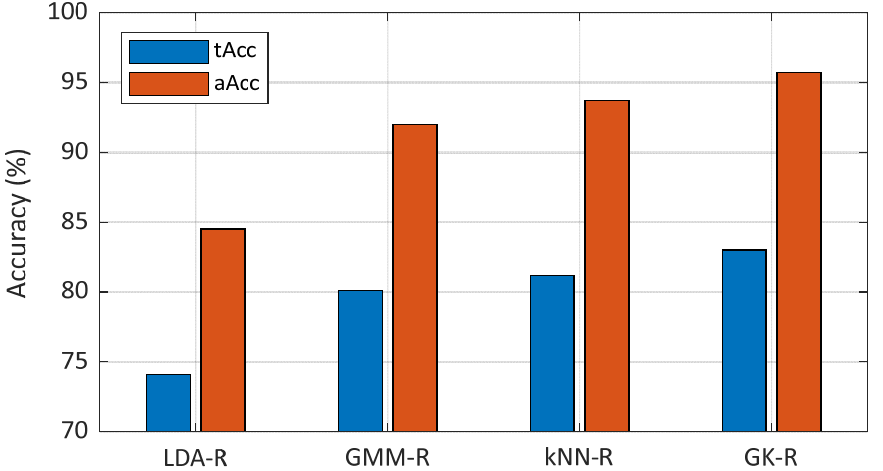
Figure 5. Comparison of classifier performance on 12 hand movements when the rejection rate is 13.0% ± 0.5%. The features used in LDA-R, GMM-R, kNN-R are WL, WL, and RMS, respectively.